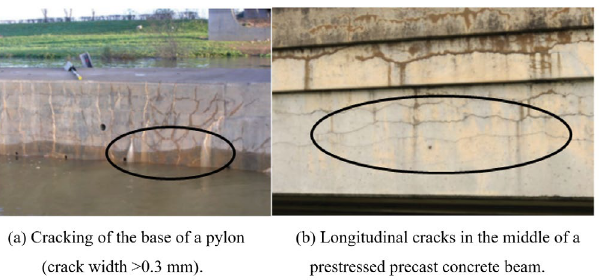
Figure 6. Cracking in the surface of concrete structures due to DEF